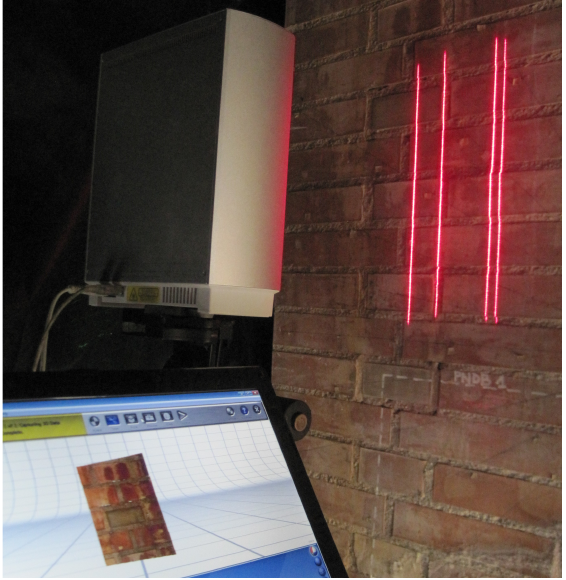
Figure 7 . A phase of survey by triangulation laser scanner Two vertical areas, respectively on the front and back wall surface, were surveyed in 2010 and 2011 (Figure 8).